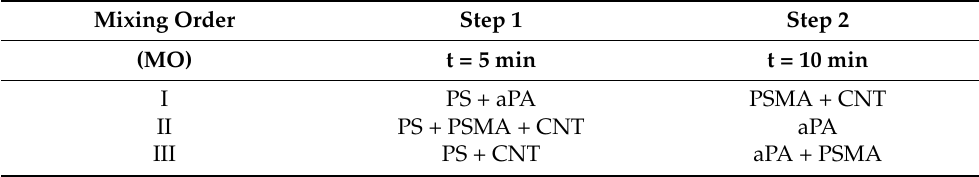
Table 1. Mixing order of